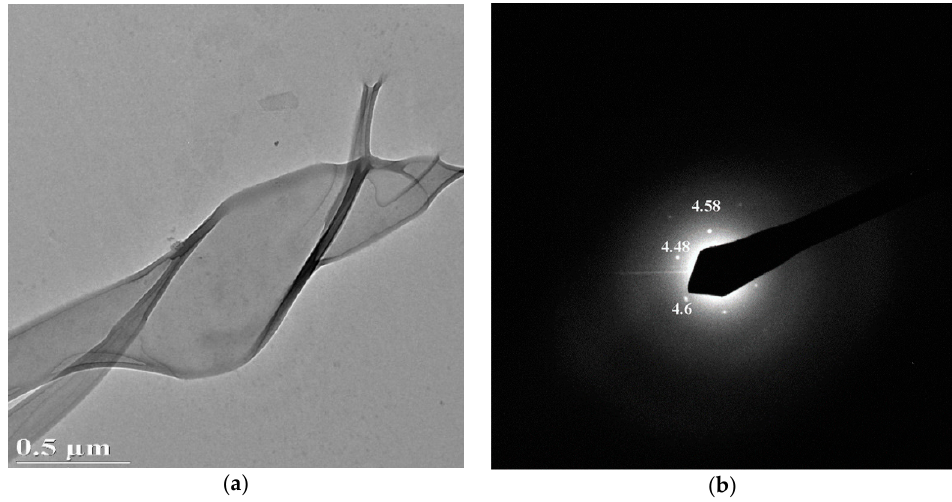
Figure 6. BF ( a ) and SAED pattern ( b ) of bacteriorhodopsin membrane after 2 min of observation.